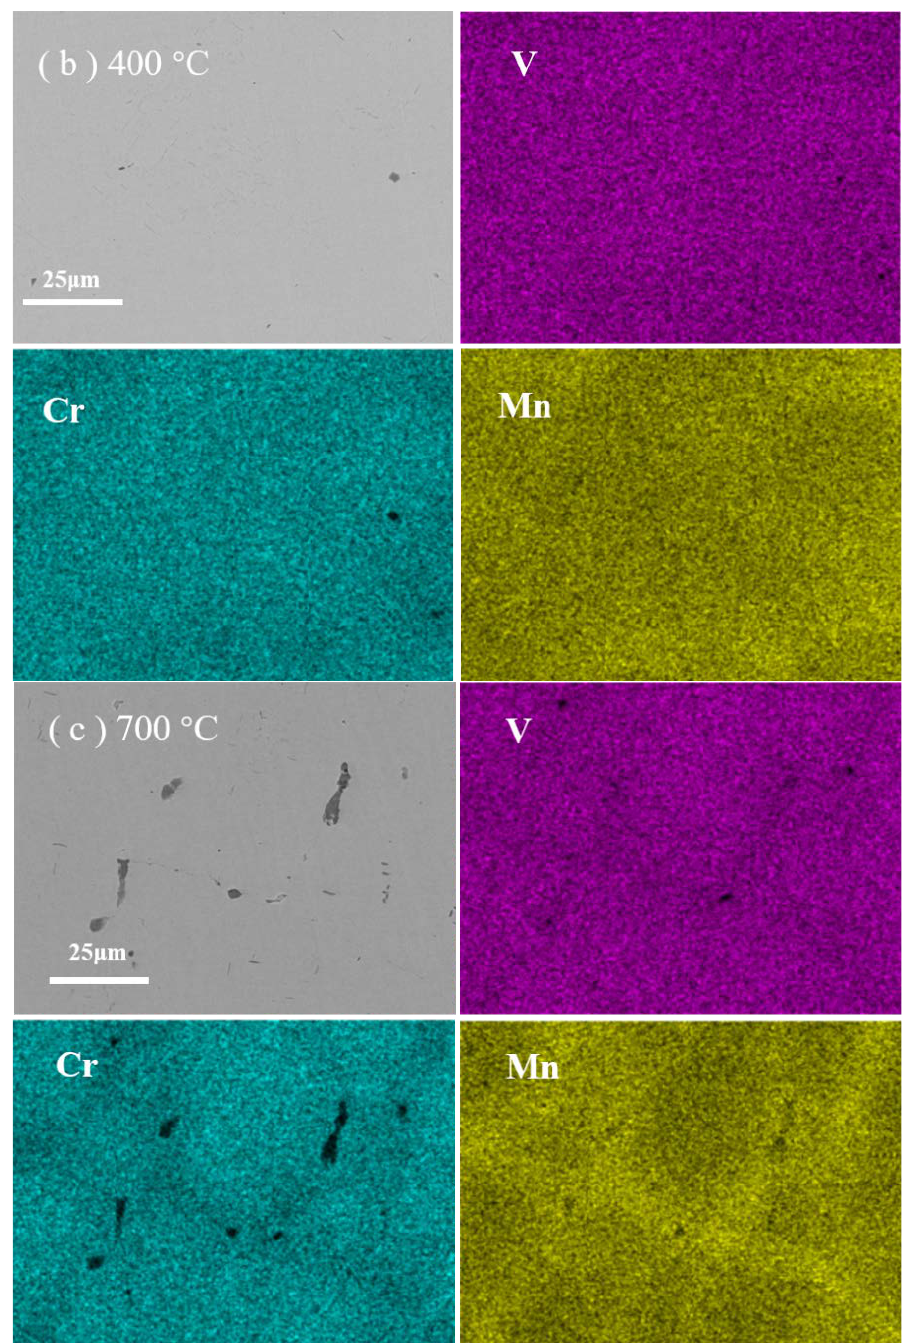
Figure 1. The SEM images and EDS mappings of ( a ) the as-cast V−Cr−Mn alloy, ( b ) V−Cr−Mn alloy after annealing at 400 °C, and ( c ) V−Cr−Mn alloy after annealing at 700 °C. Combining the SEM and XRD results, we observed that the vacancies were closely related to the migration of Cr and Mn solutes; thus, the formation of CrMn 3 precipitates could be analyzed through the interactions between the vacancies and the